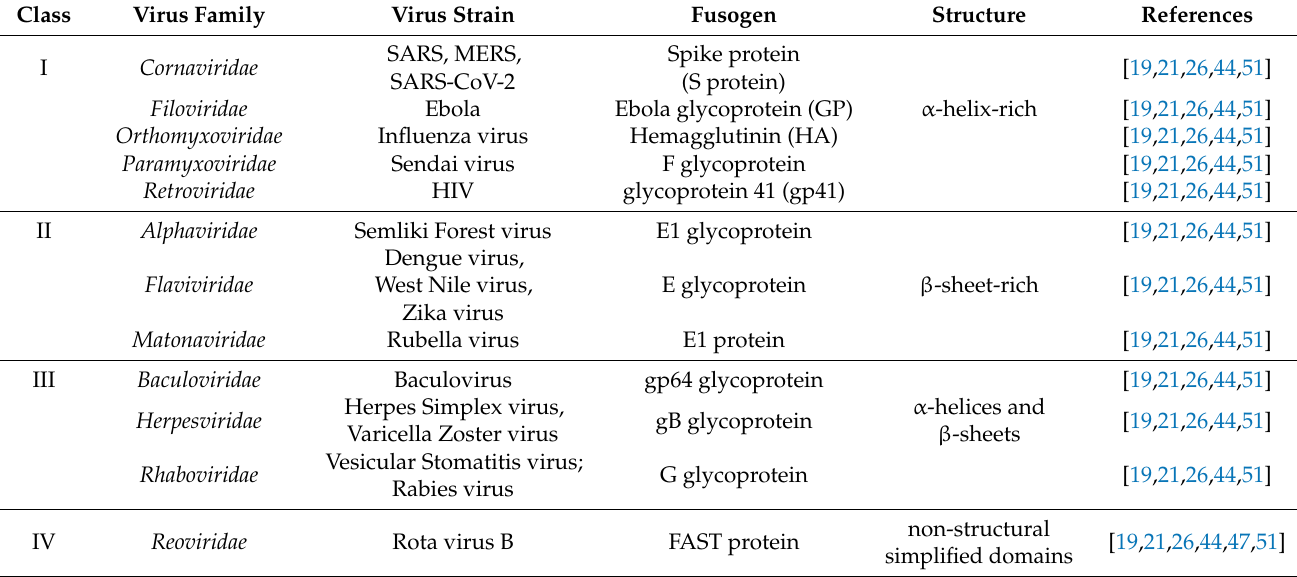
(Figure 1). Depending on their structure, virus types and accompanying viral fusogens are subdivided into four classes (Table 2). Table 2. Viral